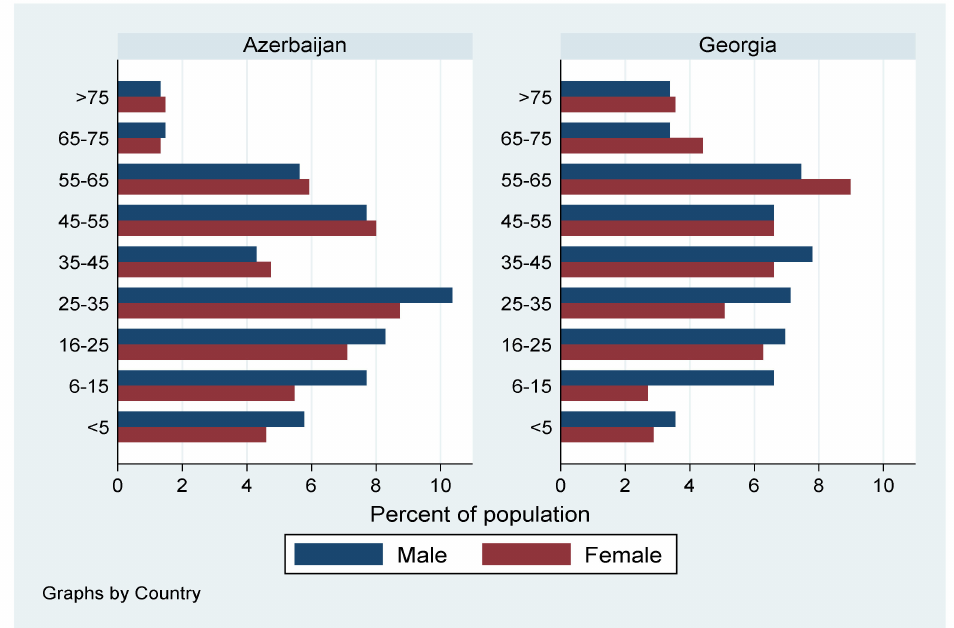
Figure 2. Age tree of the surveyed population in the Azerbaijani and Georgian study villages. Note: N = 1260, the x -axis depicts percentages of the surveyed